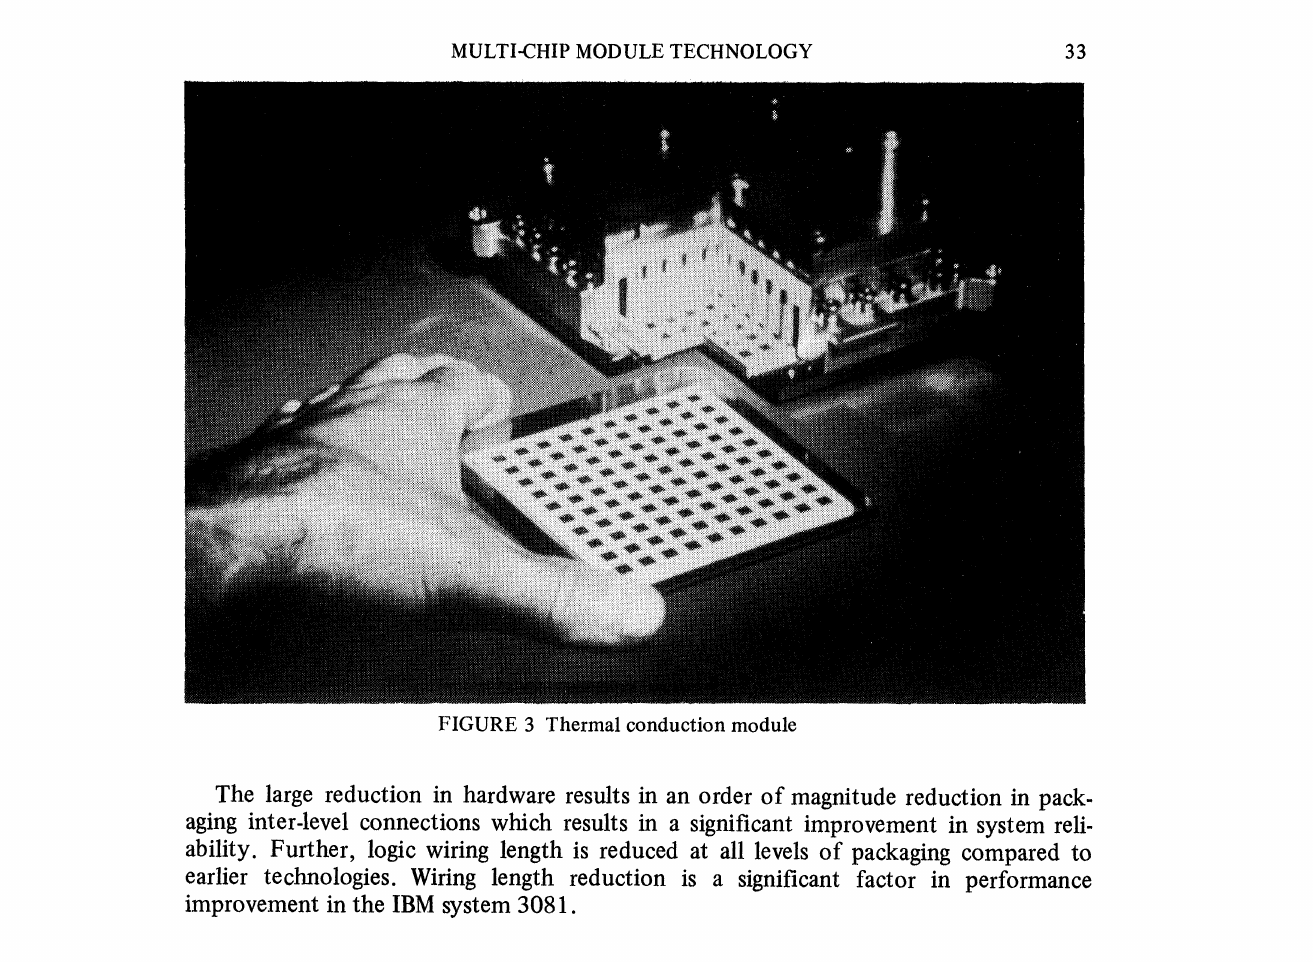
FIGURE 3 Thermal conduction